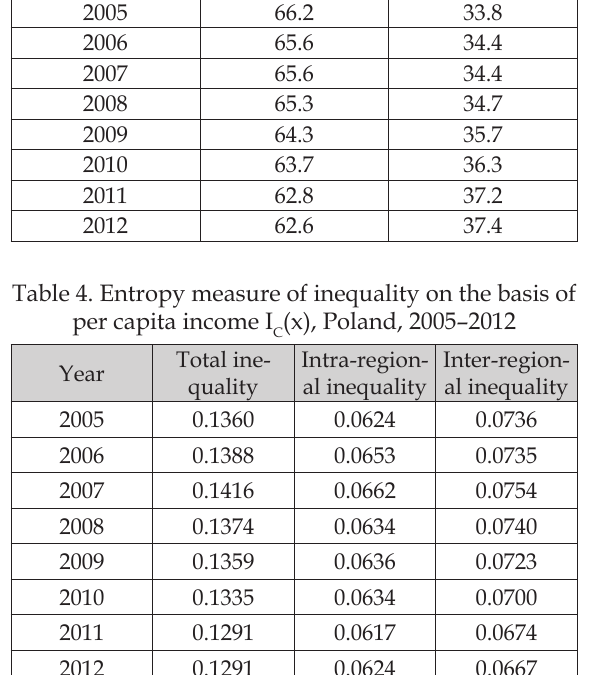
Table 3. Decomposition of total inequality I